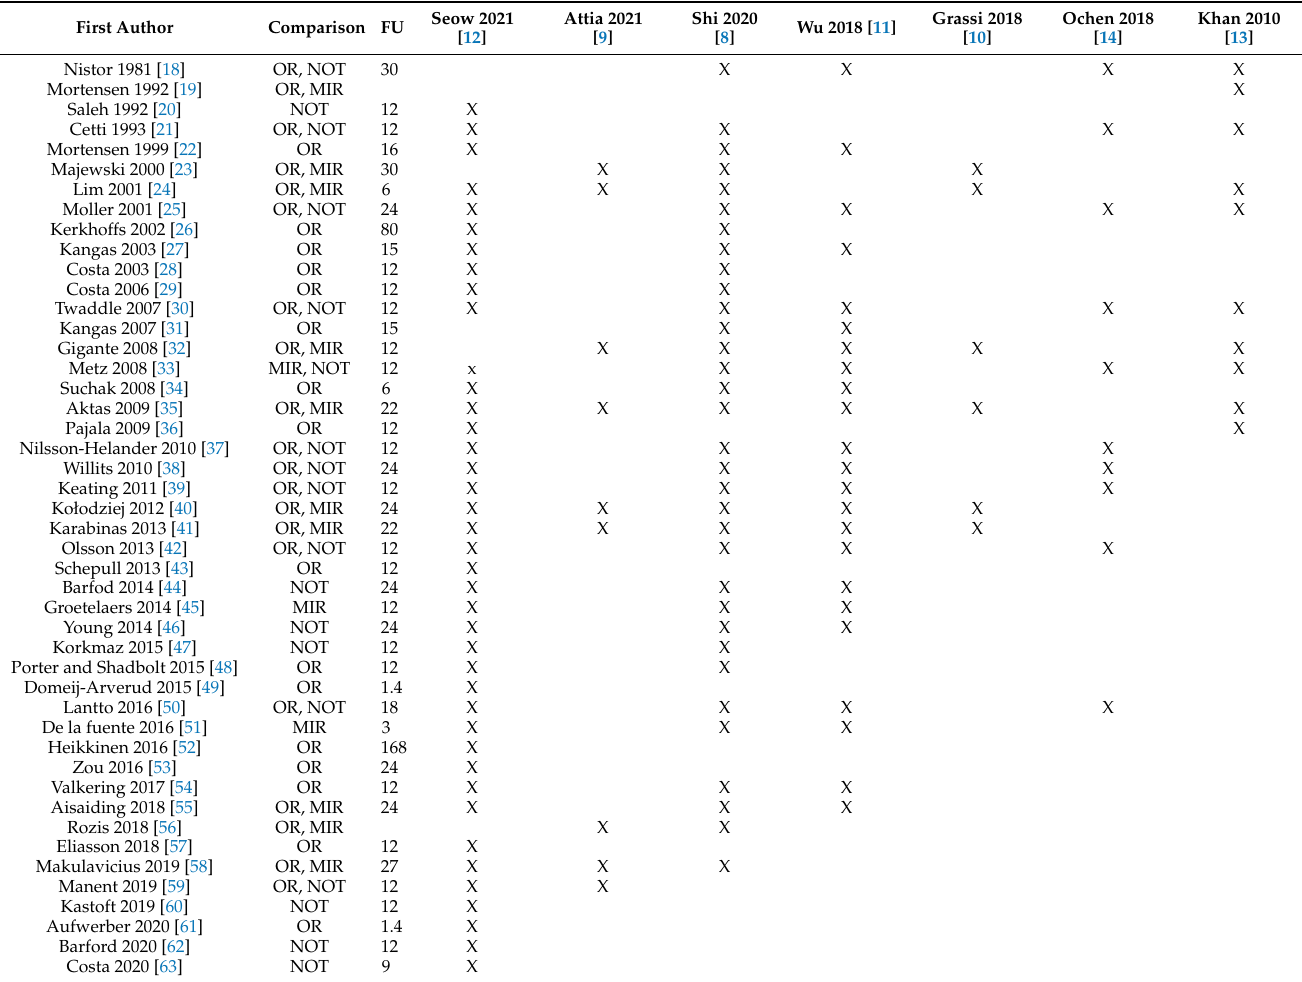
Table legend: The table shows all the available clinical trials in the literature about the treatment of the Achilles tendon rupture (leftmost column) and their inclusion or not in the seven systematic reviews included in our study (right seven columns). In the second column is specified the type of comparison performed in the trial, and in the third column the average follow-up of the patients is